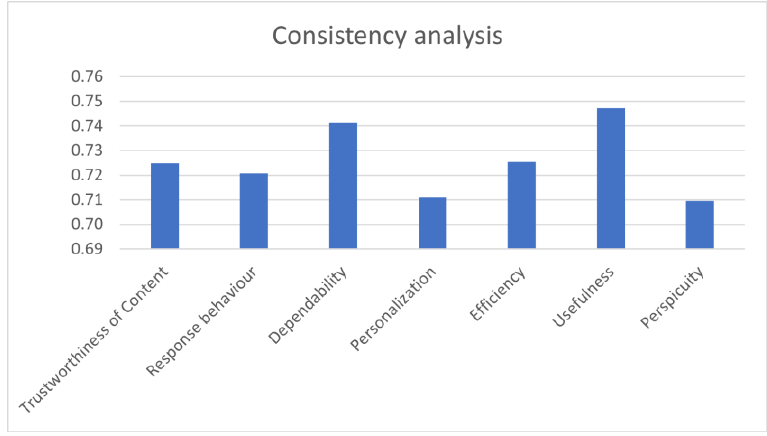
Figure 14. Cronbach’s alpha coefficient.